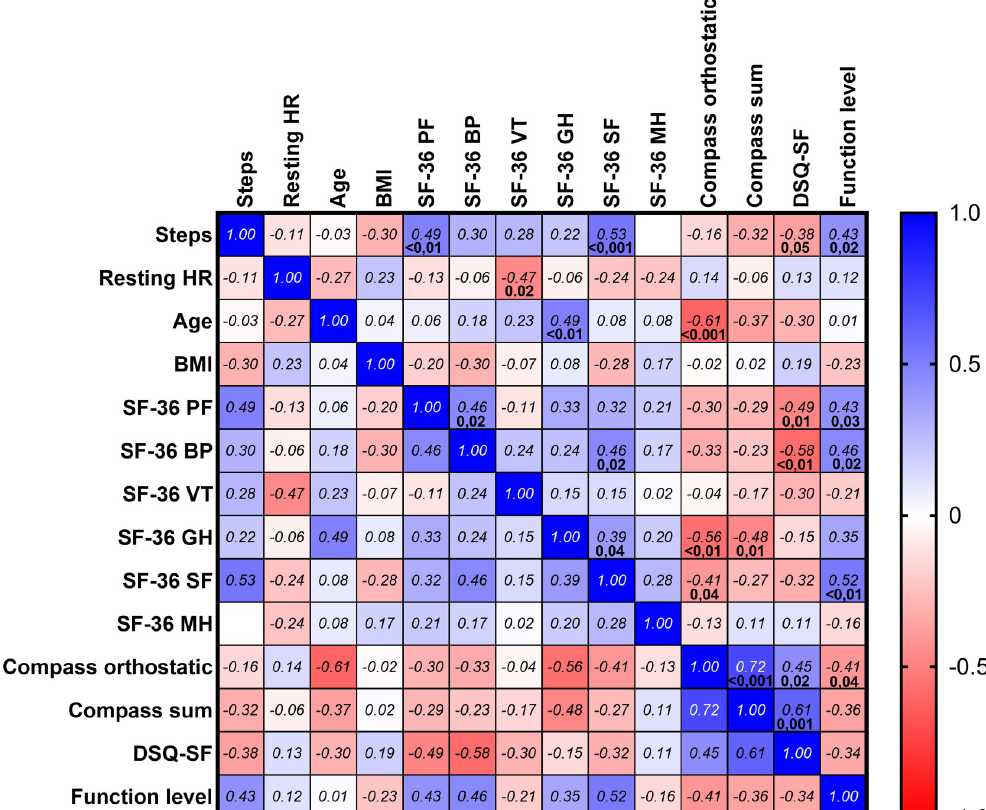
The raw scores (scale 0–100) for the six SF-36 domains (Mental health (SF-36 MH), Physical function (SF-36 PF), Bodily pain (SF-36 BP), General health (SF-36 GH), Social function (SF- 36 SF) and Vitality (SF-36 VF), recorded at four-week intervals during follow-up, are shown in Fig 6A. The Mental health score was stable during follow-up, mean 78.4 (min 73.4—max 83.4) and close to reported values for women in the general population, i.e. mean 79.9 (SD 14.8) [29]. The five other SF-36 domains showed low scores, with the lowest reported for Vitality. Baseline values for all six SF-36 domains, for all patients and divided by the three severity groups are shown in Table 1. Fig 6B shows SF-36 PF in three severity categories during follow- up, and Fig 6C SF-36 PF by categories of baseline SF-36 PF ( < 30, 30–45, > 45). Mean steps per 24 hours correlated significantly with baseline SF-36 PF (p = 0.01), SF-36 SF (p = 0.03), and baseline DSQ-SF score (p = 0.007). DSQ-SF score correlated significantly with SF-36 PF, SF-36 BP, Function level and Compass sum score. All baseline correlations are shown in Fig 4.